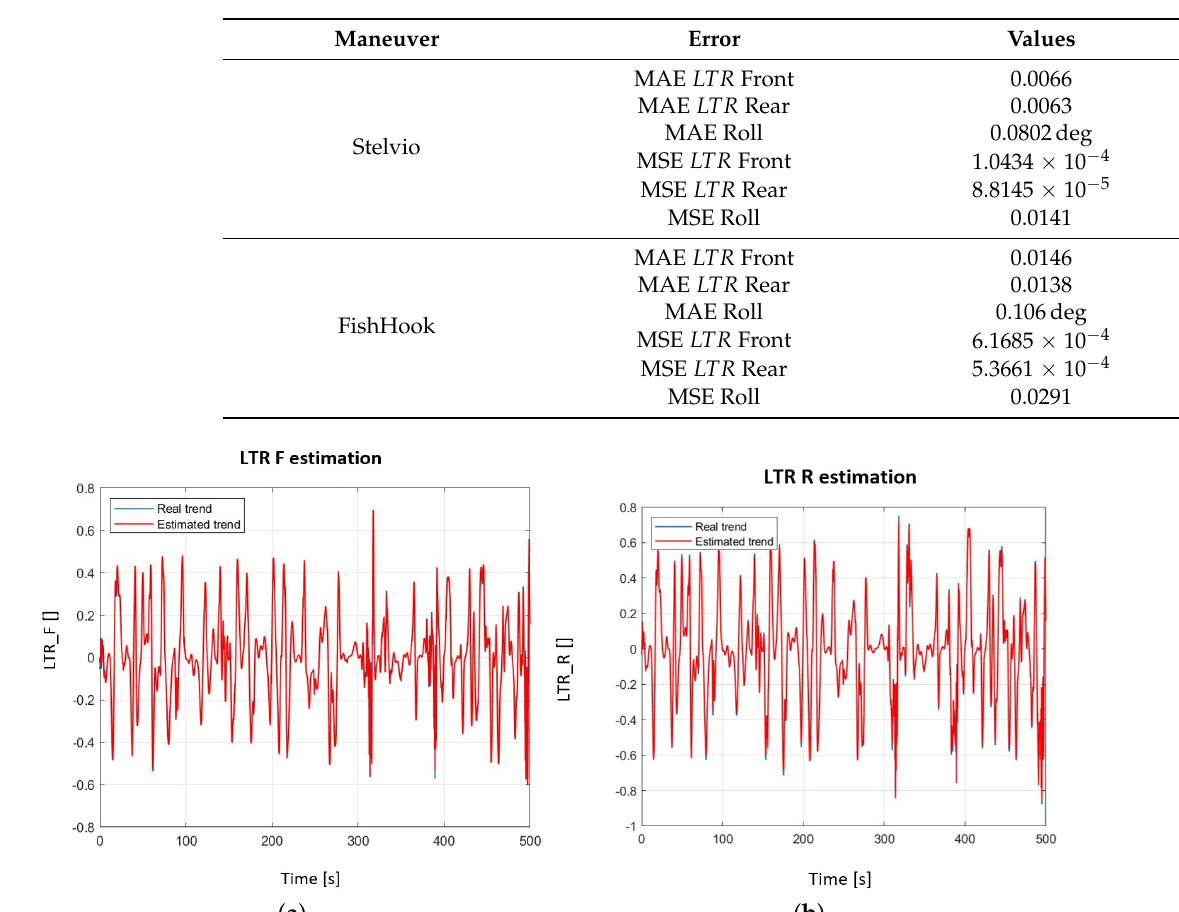
Figure 7. Estimation of the vehicle Load Transfer Ratio at front ( a ) and rear ( b ) axles driving over the Stelvio Pass.